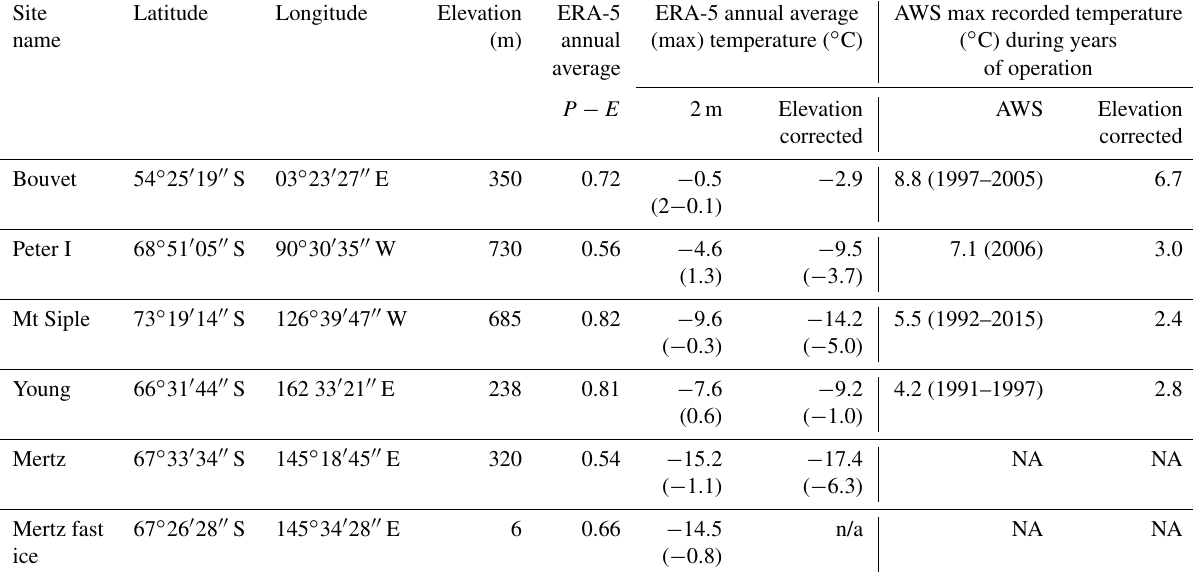
Table 1. Site metadata for the subICE cores. Measured GPS location, elevation of ice core, and ice core borehole depth. Annual average P − E , annual average temperature (maximum monthly temperature in brackets) from ERA-5 (1979–2017) at 2m elevation and corrected for ice core elevation (using a lapse rate of 0.68 ◦ /100m). Where available the maximum recorded automatic weather station (AWS) temperature is shown at the AWS elevation and corrected for ice core elevations, with years of operation in